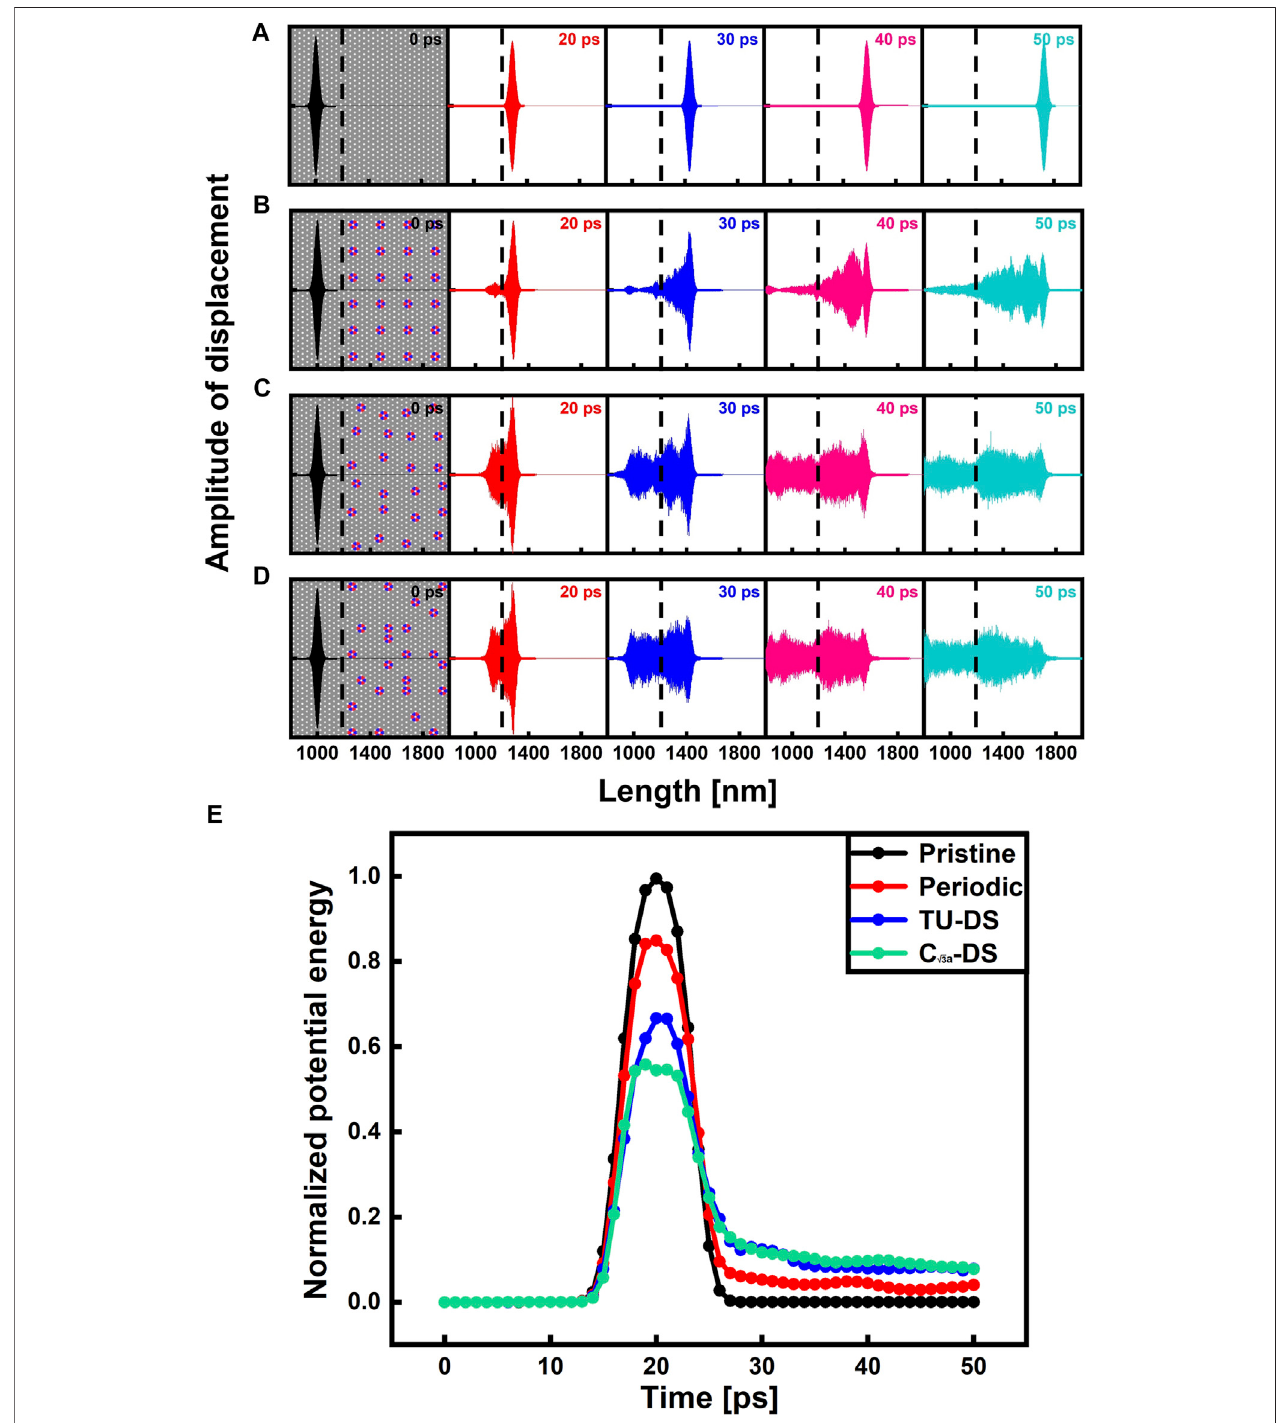
FIGURE 4 | Phonon wave-packet simulations in different structures. Snapshots of displacement for a TA wave packet in (A) pristine graphene, (B) periodic structure, (C) TU-DS, and (D) C (cid:1) 3 √ a -DS, at 0 K. The black dashed line at 1,240 nm represents the position of the interface. (E) The kinetic energy in the region of 1,240 nm – 1,340 nm in length versus time for pristine graphene, periodic structure, TU-DS, and C (cid:1) 3 √ a -DS.